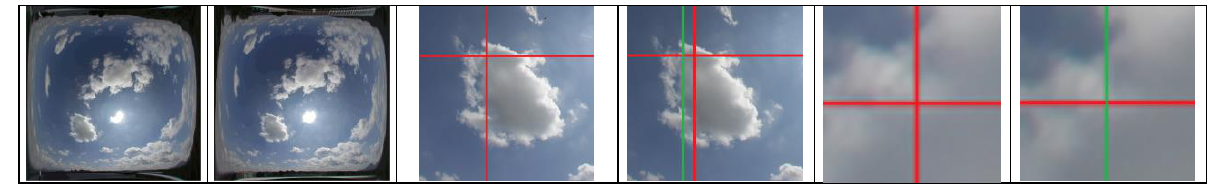
Figure 6. Matching Clouds pixels: detailed view of a cloud region from stereo